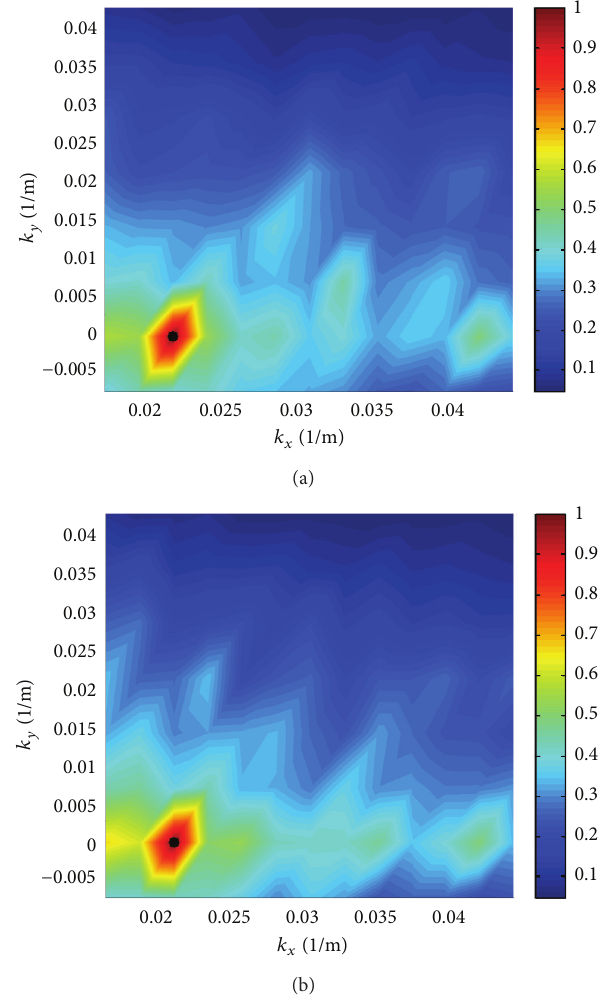
Figure 8: (a) Ensemble averaged spectrum based on all the imaged sea surfaces (i.e., from the primary events to the first multiple events after DC correction) of the first shot and (b) the ensemble averaged spectrum from the second shot. The indicated peaks of the spectra each correspond to 𝐾 𝑥 = 0.02104 and 𝐾 𝑦 = 0